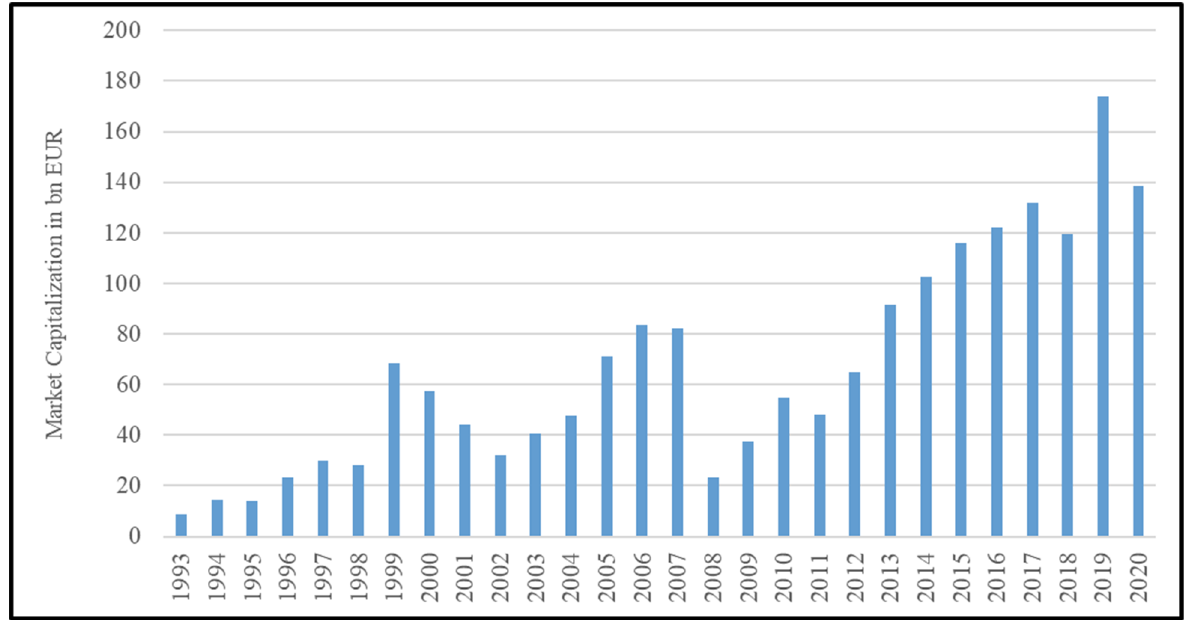
Figure 1. Market capitalization for global LPE. Source: LPX Group